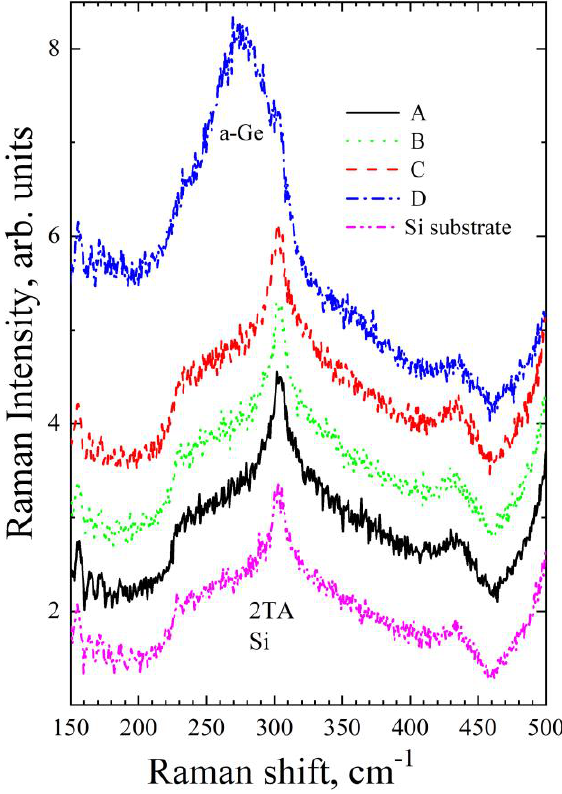
Figure 4. Raman spectra of samples A, B, C, and D, also showing the spectrum of a virgin silicon substrate.